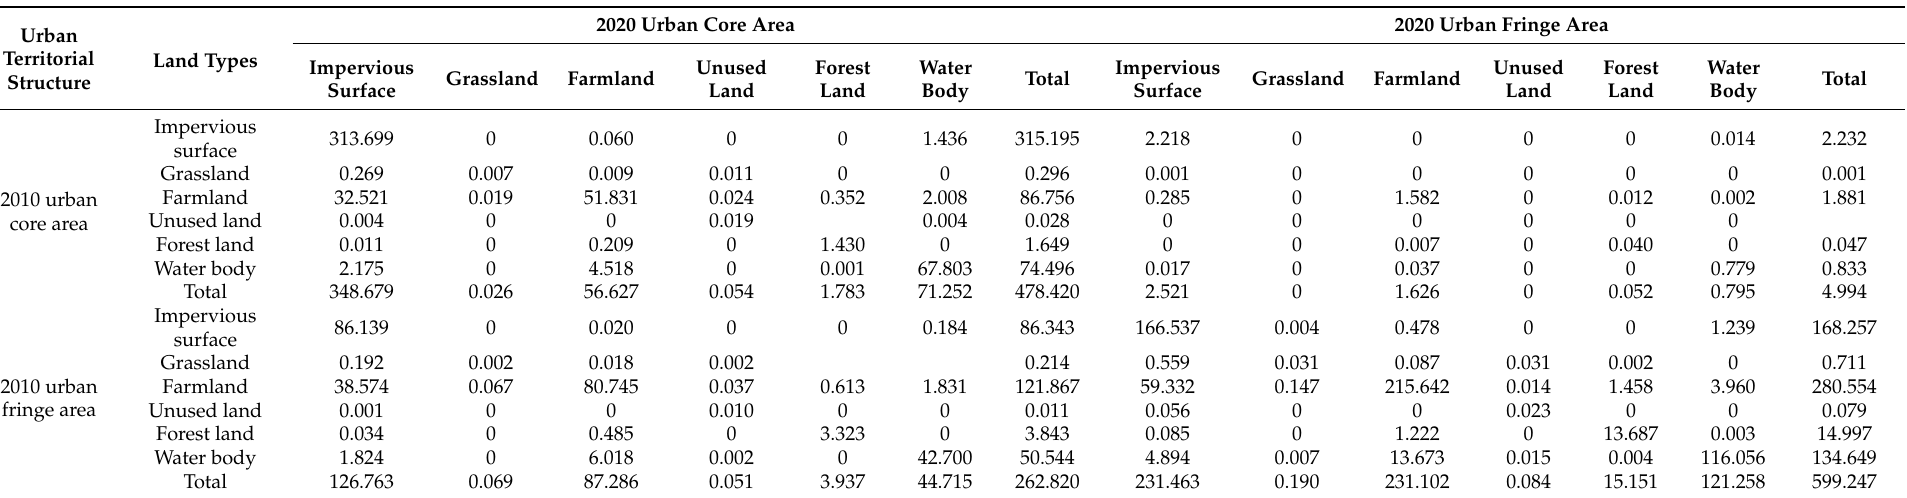
Table A3. Wuhan Land Use Transfer Matrix of urban core area and urban fringe, 2010–2020.